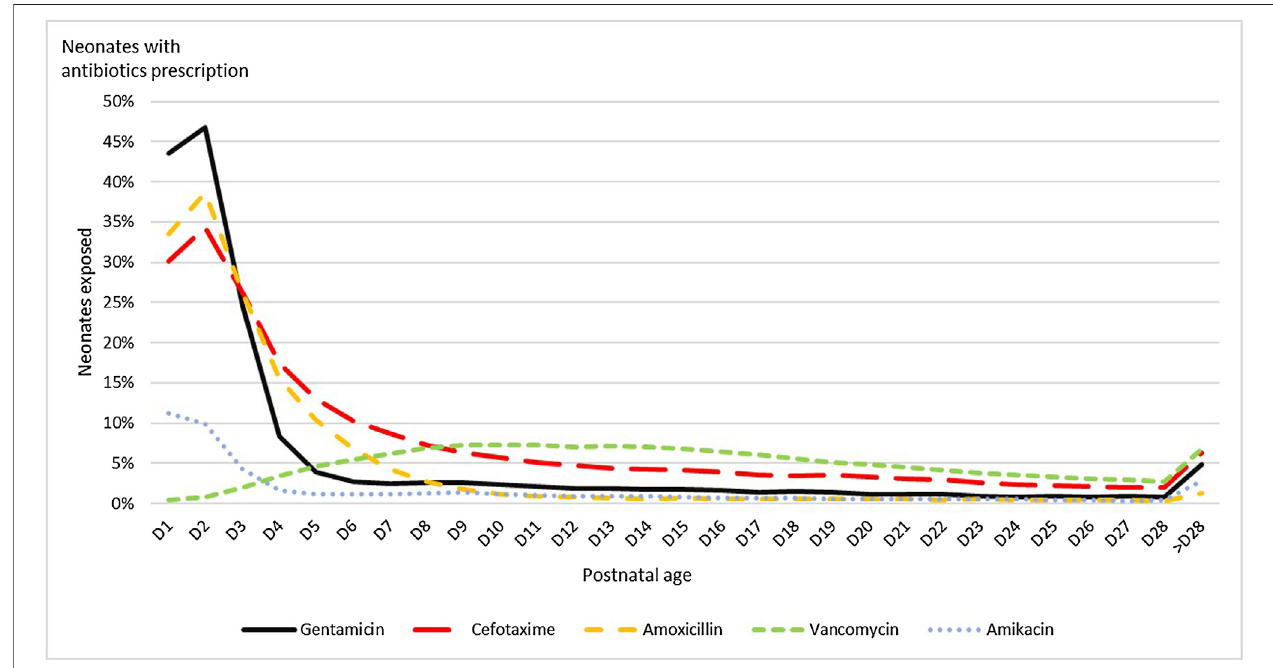
FIGURE 2 | Neonates exposure by postnatal age to the fi ve INN antibiotics most prescribed.